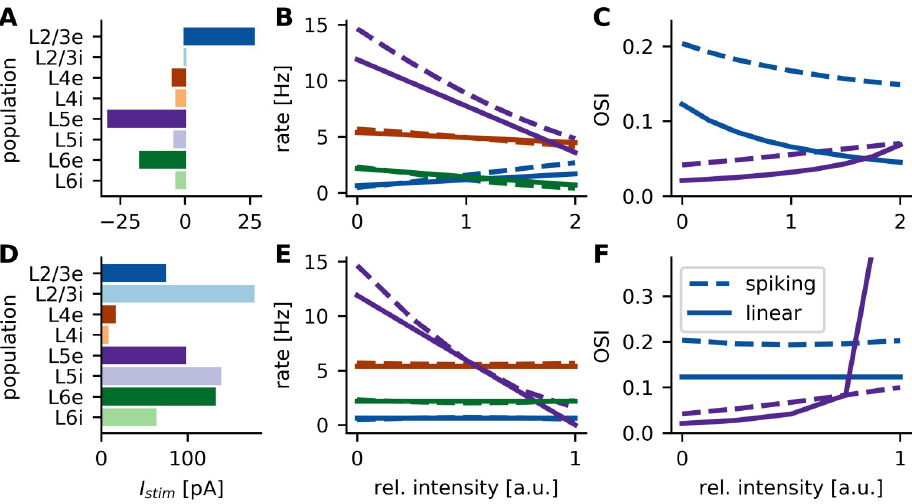
Fig 9. Predictions for future current stimulation experiments. A-C Current stimulus 1: Effective deletion of a distinct mode from the input. D-F Current stimulus 2: Selective suppression of L5e activity. A,D Single neuron current stimulation required to achieve the effect. B,E Change of the mean rate of excitatory populations upon current stimulation. Inhibitory populations are omitted for simplicity. x-axis shows current intensity relative to values in A,D, respectively. In all panels, lines represent the linear model (Model C), and dashed lines the spiking neural network simulations (Model A). C,F Change of orientation selectivity in L2/3e and L5e due to the two different current